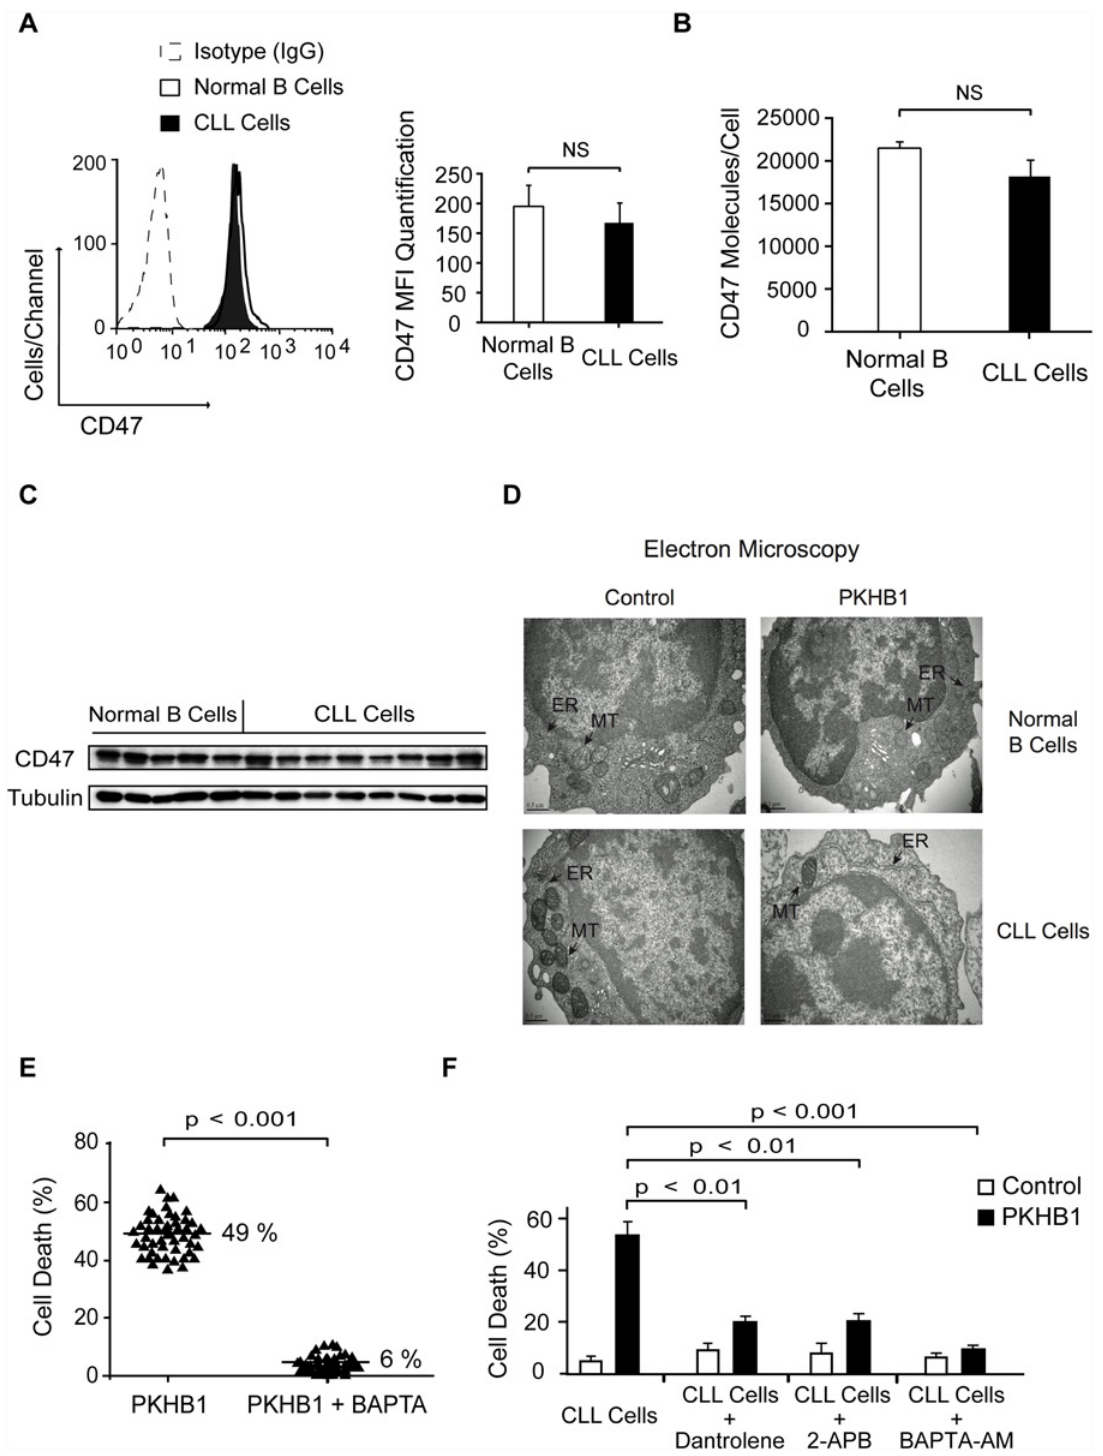
Fig 3. PKHB1 generates endoplasmic reticulum stress that provokes Ca 2+ -mediated PCD in the CLL cells. (A) CD47 expression was quantified using flow cytometry in normal and CLL B cells. A representative cytofluorometric plot is presented. In the bar chart, CD47 was quantified based on the MFI in each sample. The data are presented as mean ± SD (normal B cells, n = 20 healthy donors; CLL cells, n = 50 patients). (B) The cell surface expression of CD47 was quantified using a QuantiBRITE flow cytometry system. The number of CD47 molecules/cell in normal ( n = 5 healthy donors) and CLL ( n = 12 patients) B cells is plotted. (C) CD47 expression in normal and CLL B lymphocytes was determined by immunoblot analysis. Equal loading was confirmed by α -tubulin